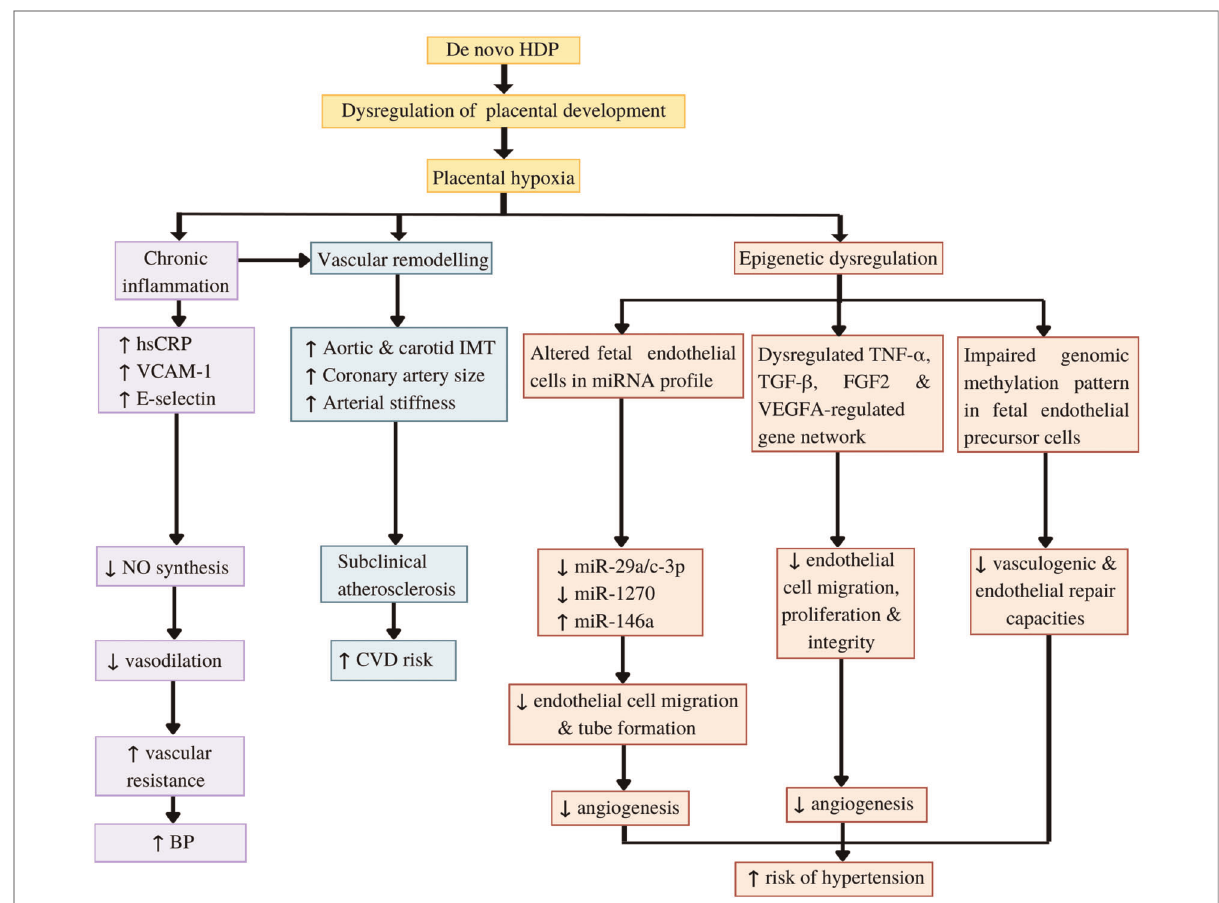
FIGURE 2 Potential mechanisms underlying the impact of de novo hypertensive disorders of pregnancy (HDP) on offspring endothelial function. HDP leads to dysregulation of placental development and placental hypoxia. Hypoxia induces chronic in fl ammation, which inhibits nitric oxide (NO) synthesis, resulting in impaired vasodilatation and increased blood pressure (BP). Both hypoxia and chronic in fl ammation cause vascular remodelling, which can be detected as subclinical atherosclerotic changes. Furthermore, hypoxia leads epigenetic dysregulation of the offspring endothelial function by causing alteration in the offspring endothelial cells and endothelial precursor cells microRNA (miRNA) pro fi le, dysregulation of several gene networks related to endothelial functions, and impaired genomic methylation pattern in the endothelial precursor cells. These epigenetic dysregulations eventually caused impaired angiogenesis and endothelial repair capacities, which increase the risk of the offspring to develop hypertension (HPT) in later life. CVD: Cardiovascular diseases, FGF2: Fibroblast growth factor 2, hsCRP: high-sensitivity C-reactive protein, IMT: intima-media thickness, TGF β 1: Transforming growth factor beta-1, TNF α : tumour necrosis factor α , VCAM-1: vascular cell adhesion molecule 1, VEGFA: vascular endothelial growth factor